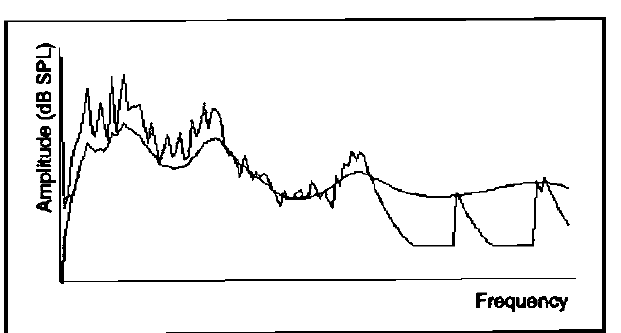
Figure 4. The spectrum after thresholding, plotted from 0 Hz to 4000 Hz (x-axis). The y-axis is the am- plitude in dB SPL. The threshold is the smooth line. The jagged line is the spectrum after thresholding.